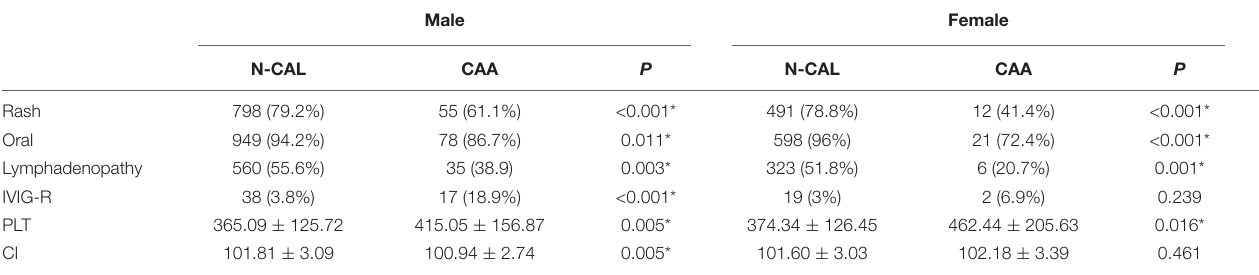
FIGURE 5 | Bar charts of the total cohort classified by sex were drawn to describe (A) the distributions of CAA and (B) the symptoms of rash, oral changes, and cervical lymphadenopathy. TABLE 4 | The comparison between N-CAL and CAA groups in male and female